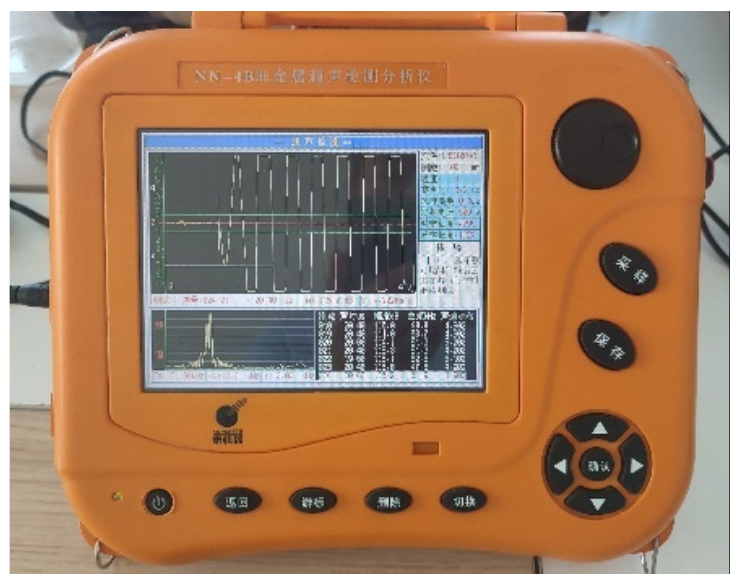
Figure 5. NN-4 B non-metal ultrasonic tester.